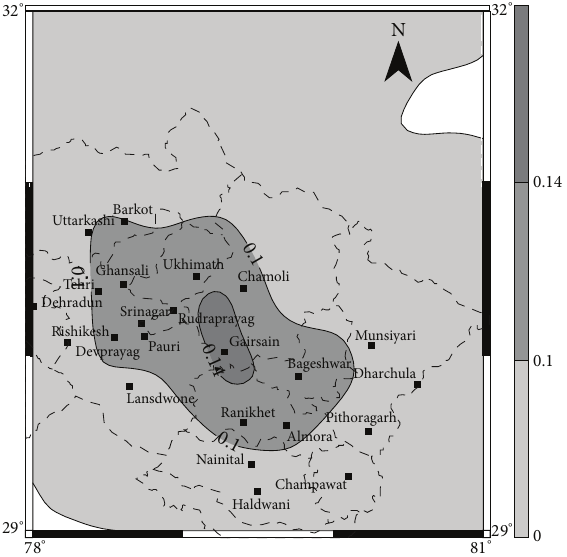
Figure 11: Seismic hazard map showing contours of 10% and 14% probability of exceedence of peak ground acceleration of value 200 gal.